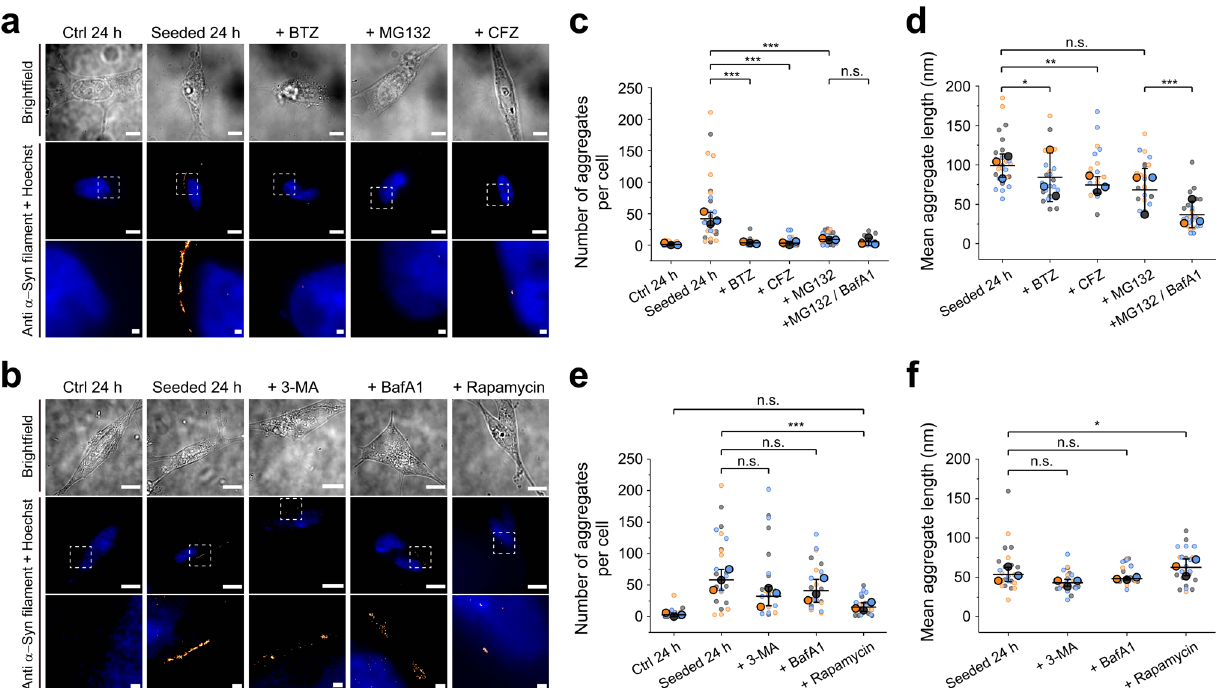
Fig. 2 The protein clearance machinery shapes α -syn aggregation in SH-SY5Y cells. After seeding with PFFs, SH-SY5Y cells were incubated DMEM/ 10% FBS supplemented with proteasomal and/or lysosomal modulators for 24 h, then α -syn aggregates detected with antibody-DNA-PAINT. BTZ: Bortezomib (5 µ M); CFZ: Car fi lzomib (1 µ M); MG132 (1 µ M); 3-MA: 3-Methyladenine (2.5 mM); BafA1: Ba fi lomycin A1 (0.4 µ M); rapamycin (60 nM). a Proteasomal inhibition reduces α -syn aggregation in SH-SY5Y cells. b Autophagy-lysosomal pathway does not remove α -syn ef fi ciently in SH-SY5Y cells. Nuclei are stained blue with Hoechst dye; super-resolved α -syn aggregates are shown in red. Inhibiting the proteasome decreased the number of aggregates per cell ( c ) but not the aggregate length ( d ). In contrast, inhibiting autophagy did not affect the number of α -syn aggregates ( e ) but stimulating autophagy with rapamycin restored protein clearance; neither treatment affected aggregate length ( f ). Statistical difference was determined by one-way ANOVA with Tukey ’ s multiple comparison test. The cells were separately pooled for each biological replicate ( n = 3) and the median calculated for each pool; those three medians were then used to calculate the mean (horizontal bars), standard deviation (error bars), and p values. * p < 0.05, ** p < 0.01, *** p < 0.001, n.s. not signi fi cant; the difference of the means is not signi fi cant at the 0.05 level. For proteasomal inhibition, N = 30, 29, 29, 30, 28, 27 for Ctrl 24 h, Seeded 24 h, + BTZ, + MG132, + CFZ, + MG132/BafA1, respectively, from three biological replicates. For autophagy inhibition/induction, the total number of cells imaged N = 21, 24, 24, 22, 23 for Ctrl 24 h, Seeded 24 h, + 3-MA, + BafA1, + Rapamycin, respectively, from three biological replicates. Scale bars in a and b (from top to bottom): 10, 10, and 1 µ